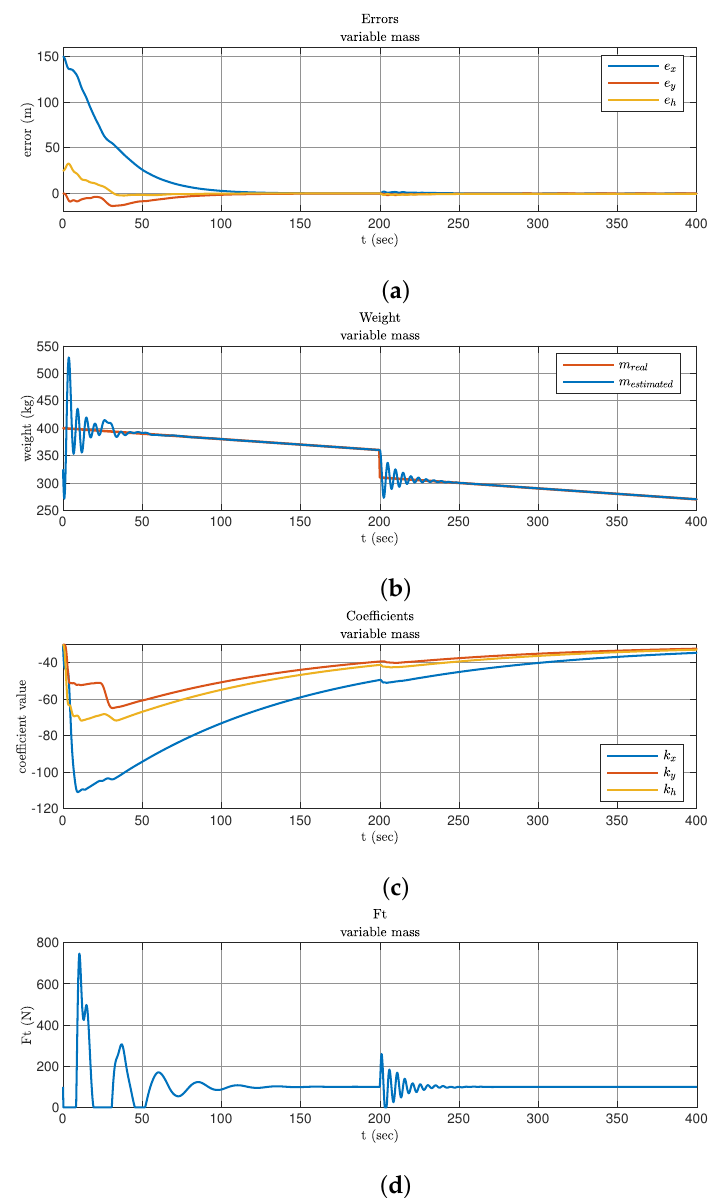
Figure 5. Coordinate errors ( a ), estimated mass value ( b ), controller gains ( c ), and thrust force ( d ) for scenario of jumplike UAV mass